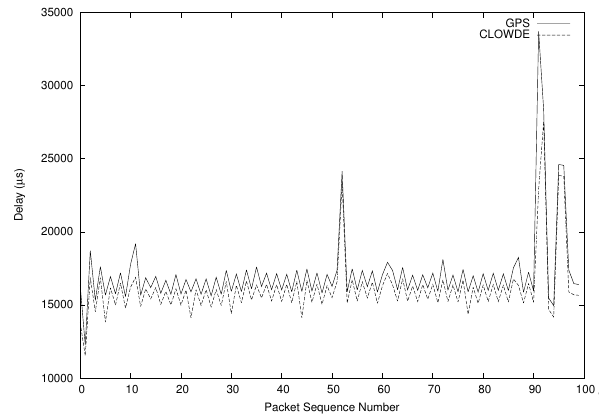
Figure 15. CLOWDE delay correction error. Fig. 15: Clowde delay correction error Fig. 15: Clowde delay correction error Table 3. Sampling time accuracy among three